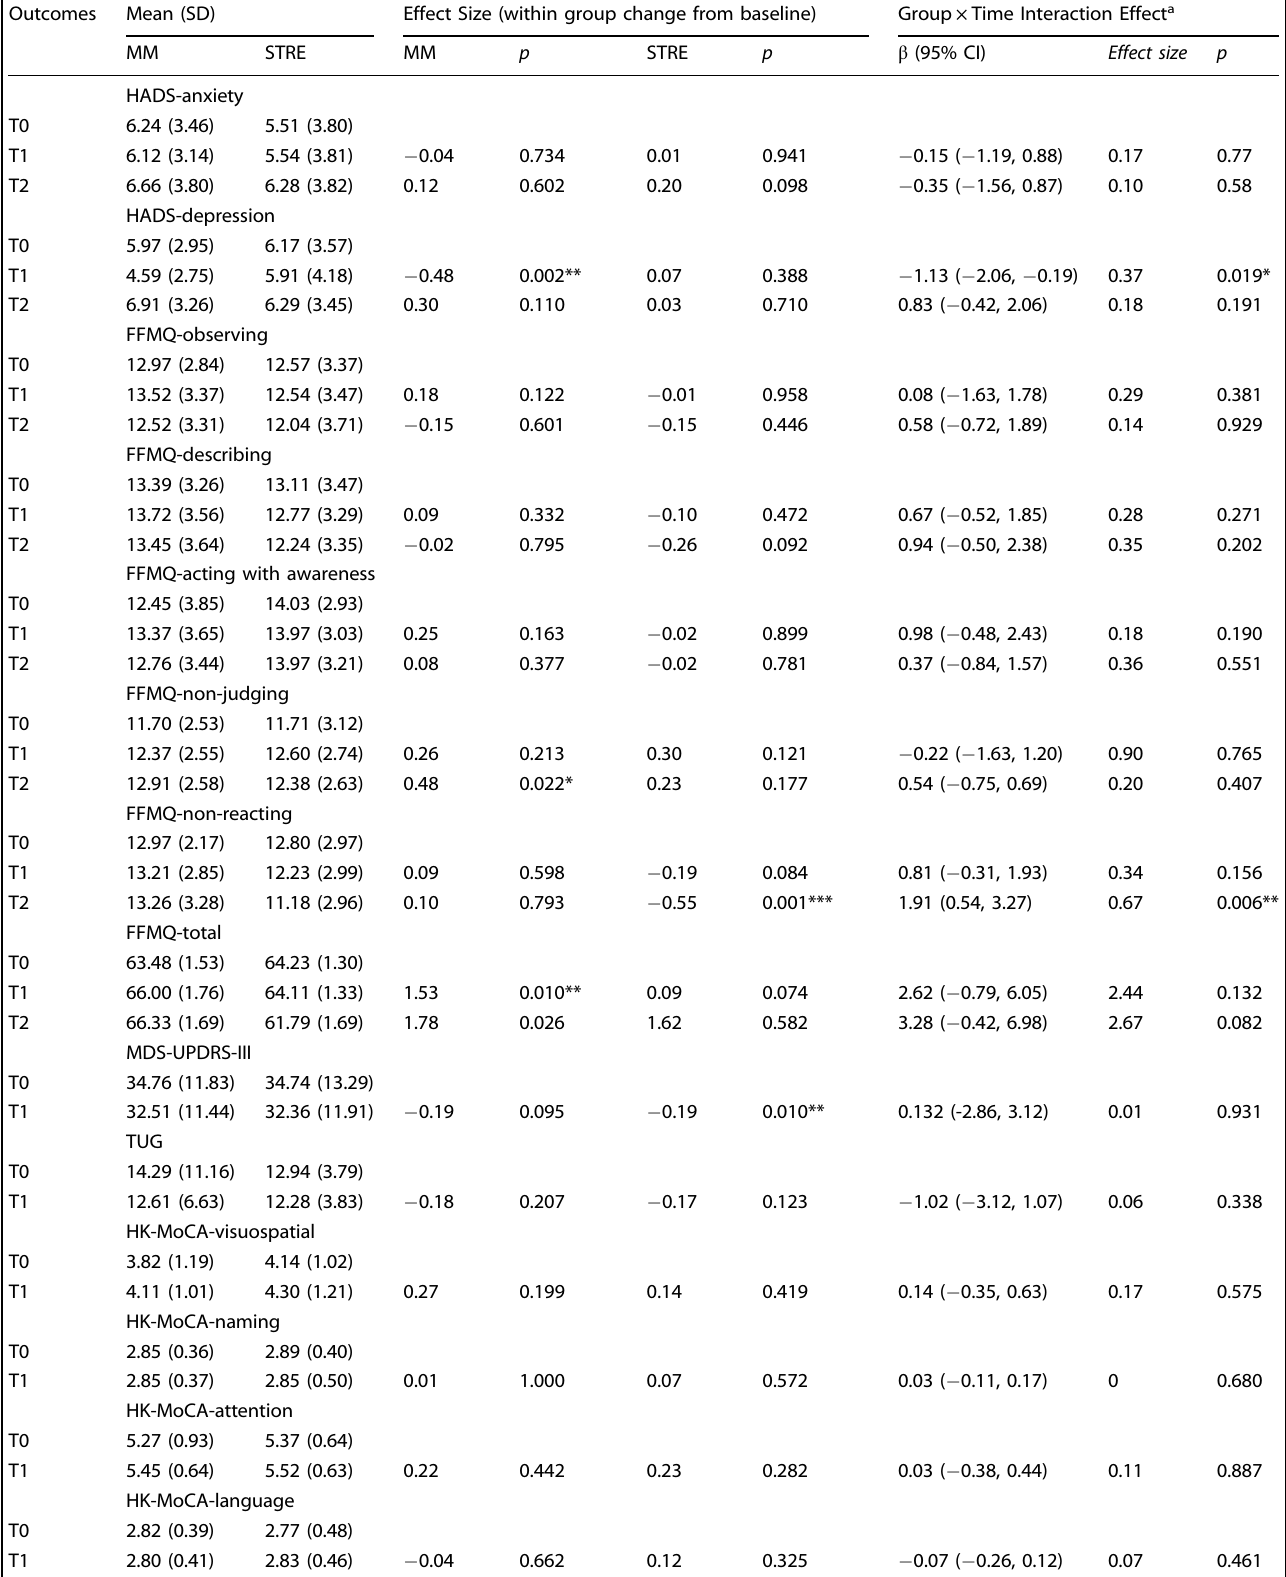
Table 2. Analysis of GEE for the comparison of outcomes ( n = 68).